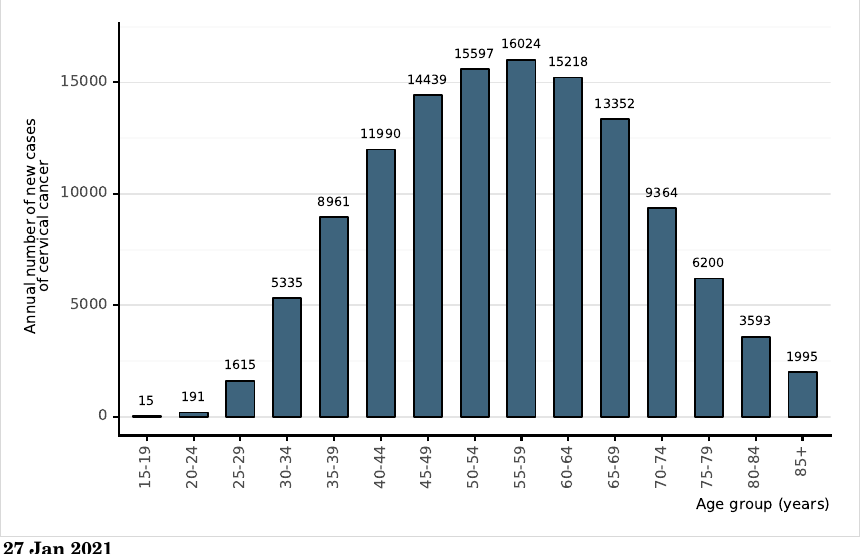
Figure 9: Annual number of new cases of cervical cancer in India (estimates for